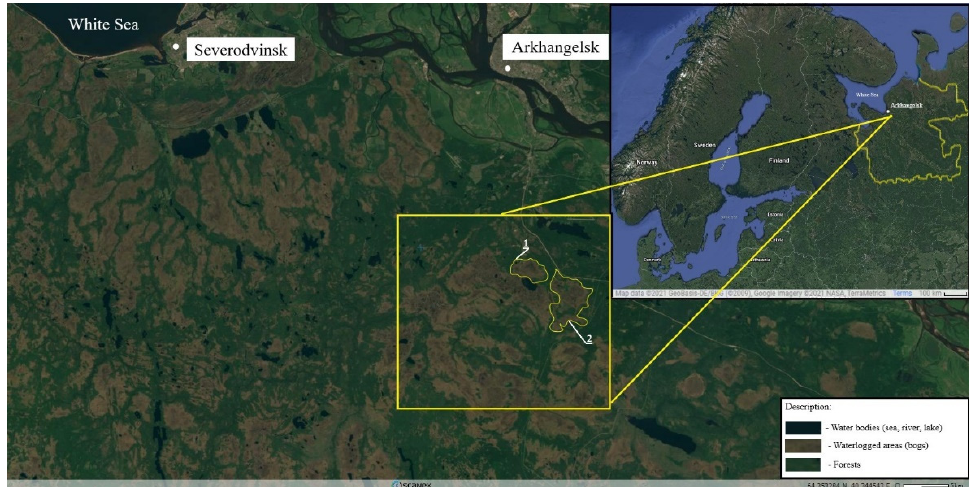
Figure 1. The study area in the waterlogged Northern Dvina River basin. 1—Ilas oligotrophic bog